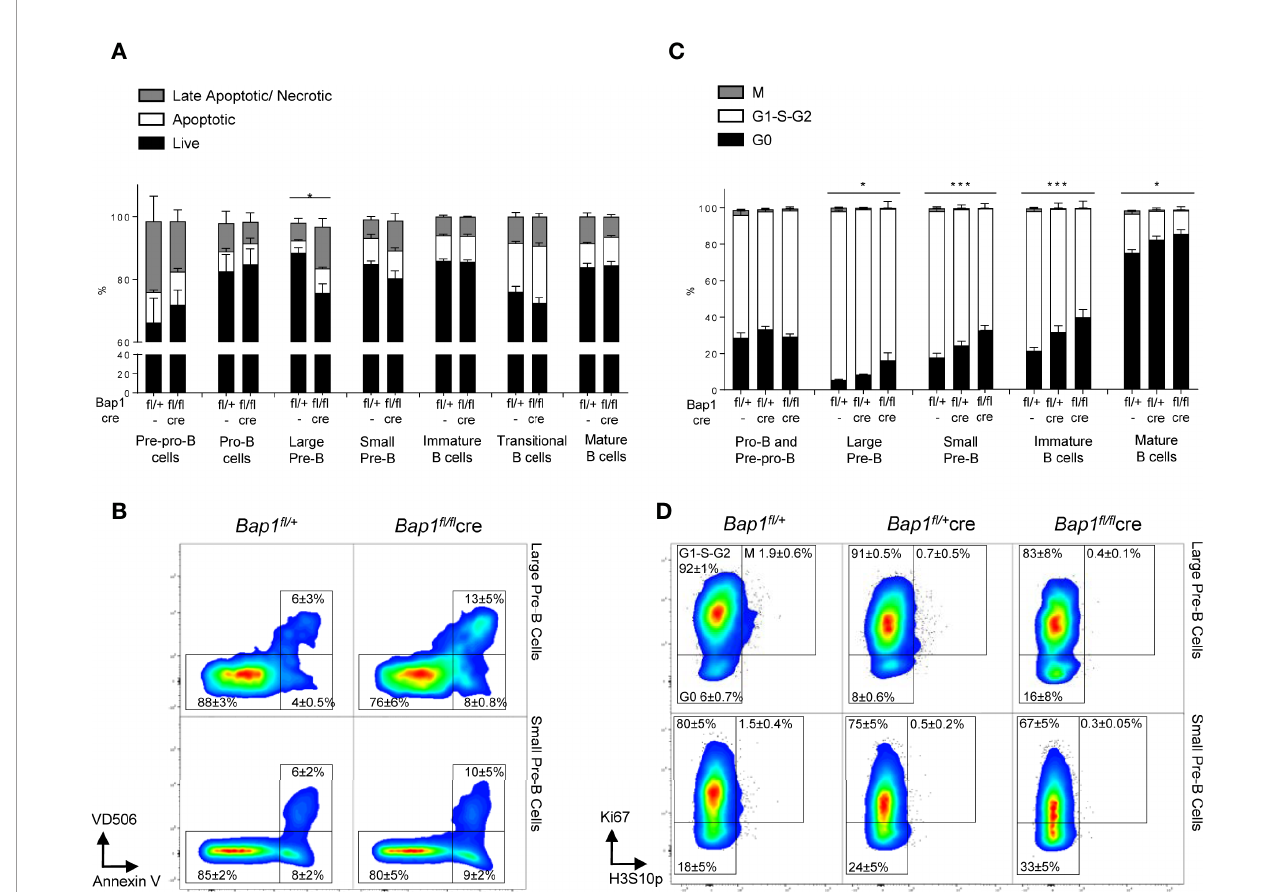
FIGURE 3 | Impact of Bap1 -de fi ciency on the B cell lineage cell viability and cell cycle progression. (A, B) Impaired viability of large pre-B cells in Bap1 fl / fl Cre mice. Bone marrow and splenocytes of mice of Bap1 fl /+ and Bap1 fl / fl Cre genotypes were stained with Annexin V to identify apoptotic cells and with Viability Dye V506 (eBioscience) to identify necrotic cells, as well as for cell surface markers to identify mature splenic B cells (B220 + IgM + IgD + ), transitional splenic B cells (B220 + IgM + IgD - ), immature bone marrow B cells (B220 + IgM + IgD - ), small pre-B cells (B220 + IgM - IgD - CD19 + CD43 - FSC lo ), large pre-B cells (B220 + IgM - IgD - CD19 + CD43 - FSC hi ), pro-B cells (B220 + IgM - IgD - CD19 + CD43 + ), and pre-pro-B cells (B220 + IgM - IgD - CD19 - CD43 + ). (A) Frequency of live (AnxV - V506 - ), early apoptotic (AnxV + V506 - ), and late apoptotic/necrotic (AnxV + V506 + ) cells within each B cell subpopulation in Bap1 fl / fl Cre and control mice. Bars represent mean ± SEM; n=4 mice were analyzed per genotype in total over two independent experiments; statistical analysis used ANOVA, *p < 0.05. (B) Representative fl ow cytometry density plots, gated on the large and small pre-B cells and showing the reduced frequency of live cells and increased frequency of late apoptotic/necrotic cells for the large pre-B cells in Bap1 fl / fl Cre mice. Cell frequency in each gate is indicated as mean ± S.D. (C, D) Impaired cell-cycle progression in Bap1 fl / fl Cre B cells. Bone marrow of mice of Bap1 fl /+ , Bap1 fl /+ Cre , and Bap1 fl / fl Cre genotypes was stained for Ki67 and histone H3S10p, to identify G0 (Ki67 - H3S10p - ), G1-S-G2 (Ki67 + H3S10p - ), and M phase (Ki67 + H3S10p + ) cells. (C) Frequency of G0, G1-S-G2, and M phase cells within each B cell subpopulation, showing impaired cell cycle progression from the pre-B stage in development onward in Bap1 fl / fl Cre mice. Bars represent mean ± SEM; n=4 mice were analyzed per genotype in total over two independent experiments; statistical analyses were performed using ANOVA; *p < 0.05, ***p < 0.001, or not signi fi cant if not indicated. (D) Representative fl ow cytometry density plots, gated on large and small pre-B cells and showing elevated frequency of G0 cells and reduced frequency of G1-S-G2 cells in Bap1 fl / fl Cre mice; cell frequency in each gate is indicated as mean ±